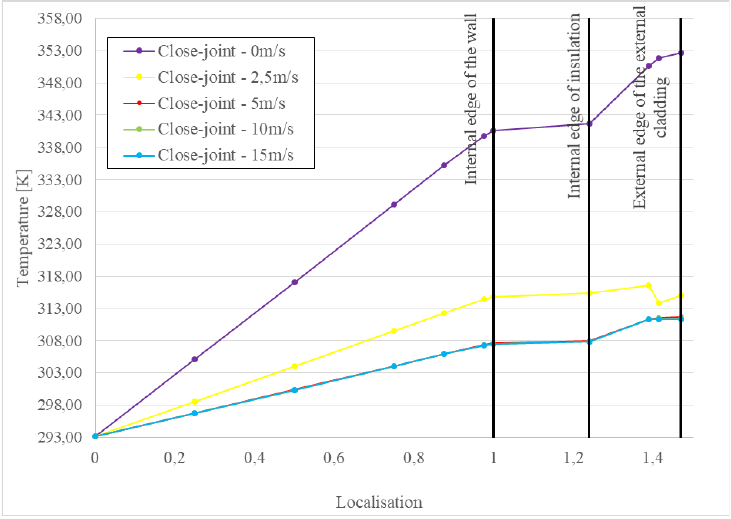
Figure 14: Temperature overview for the control points of the close-joint